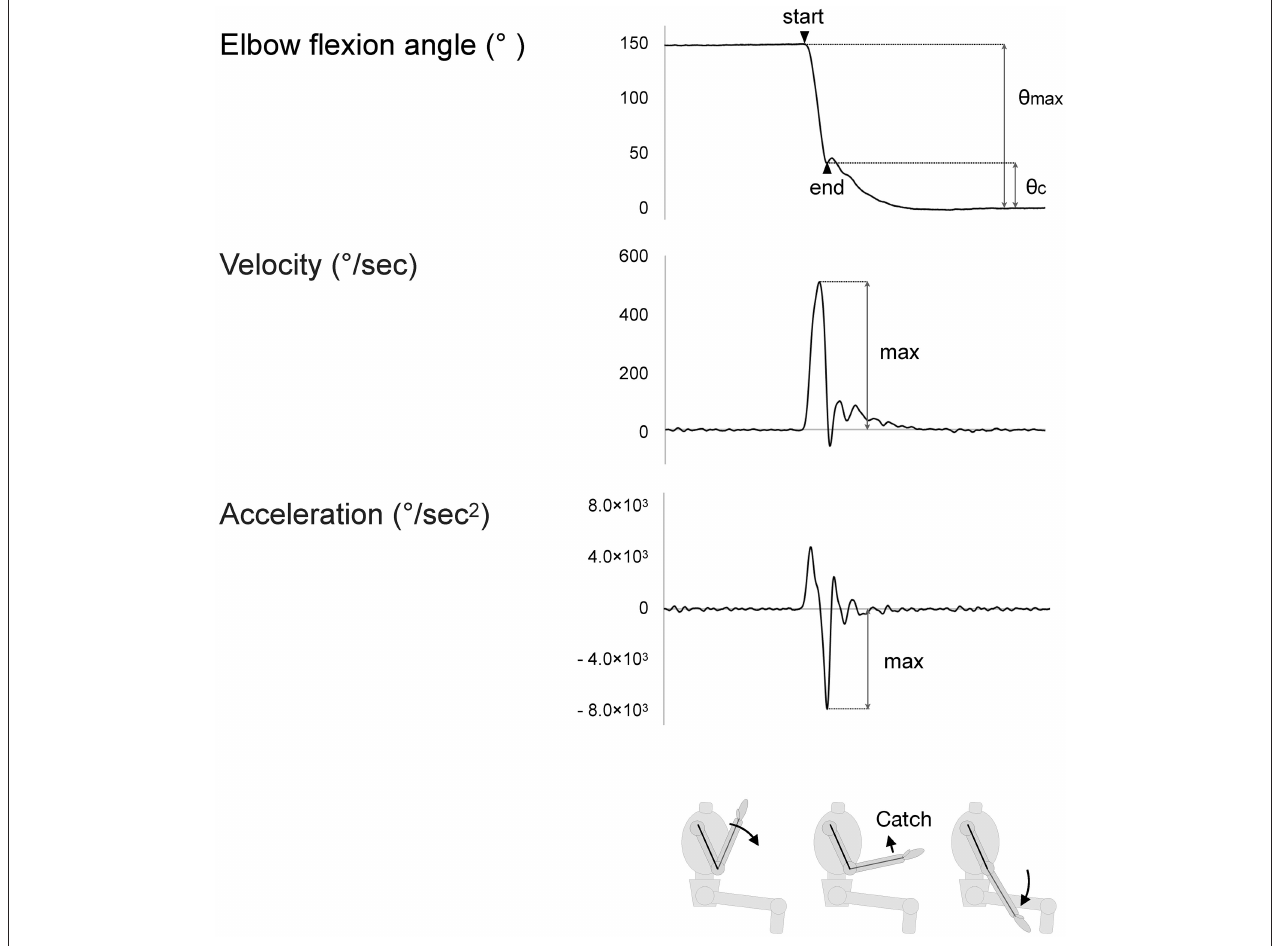
FIGURE 2 | The maximum values of indices. Velocity rises as passive movement in the elbow joint begins. Acceleration similarly rises but falls with deceleration of the motion. The value of deceleration is considered to reflect the strength of the “catch” of the spastic